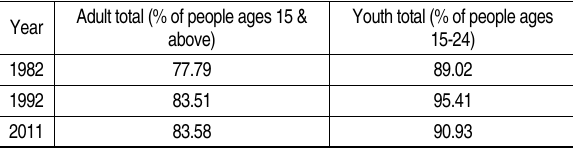
Table 1. Literacy rate in Zimbabwe